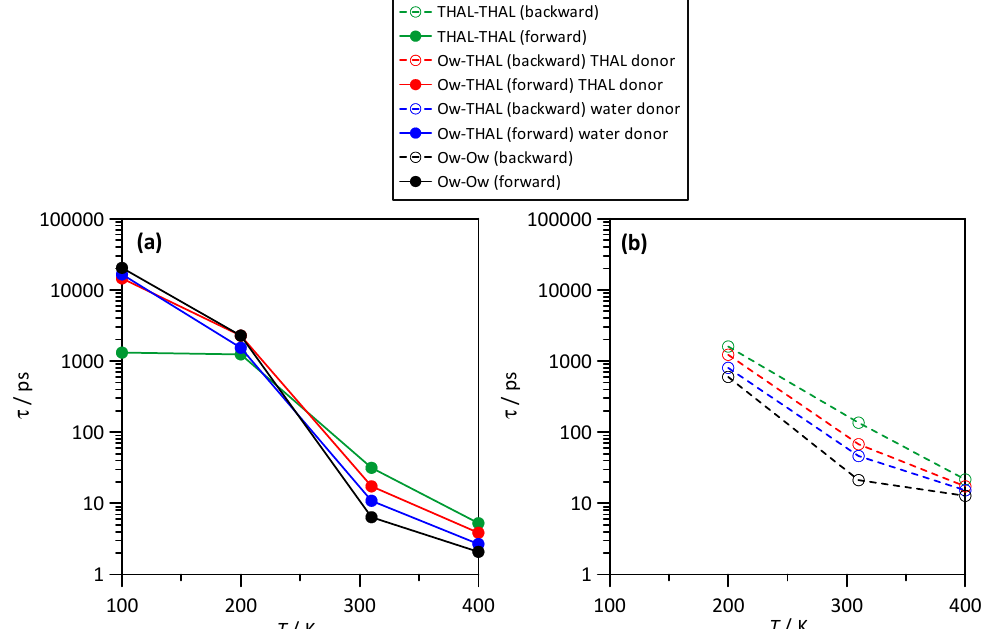
Figure 15. Kinetic parameters of hydrogen bonding for the reported interacting sites showing relaxation times, τ , for the ( a ) forward, i.e., hydrogen bond lifetime, and ( b ) backward, i.e., hydrogen bonding reformation after destruction, processes in ω THAL + (1- ω ) water mixtures ( ω = 0.112) as a function of temperature. Atom labels as in Figure 1. For THAL molecule, all available OH sites (O1 to O4, Figure 1) are considered as donor or